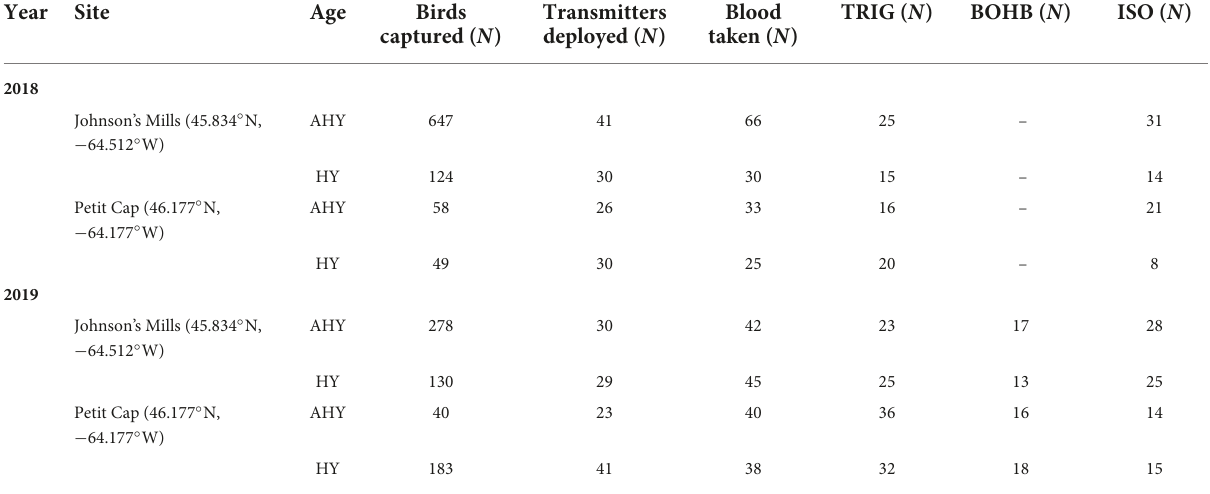
TABLE 1 Details of capture locations, dates, and sample collection for Semipalmated